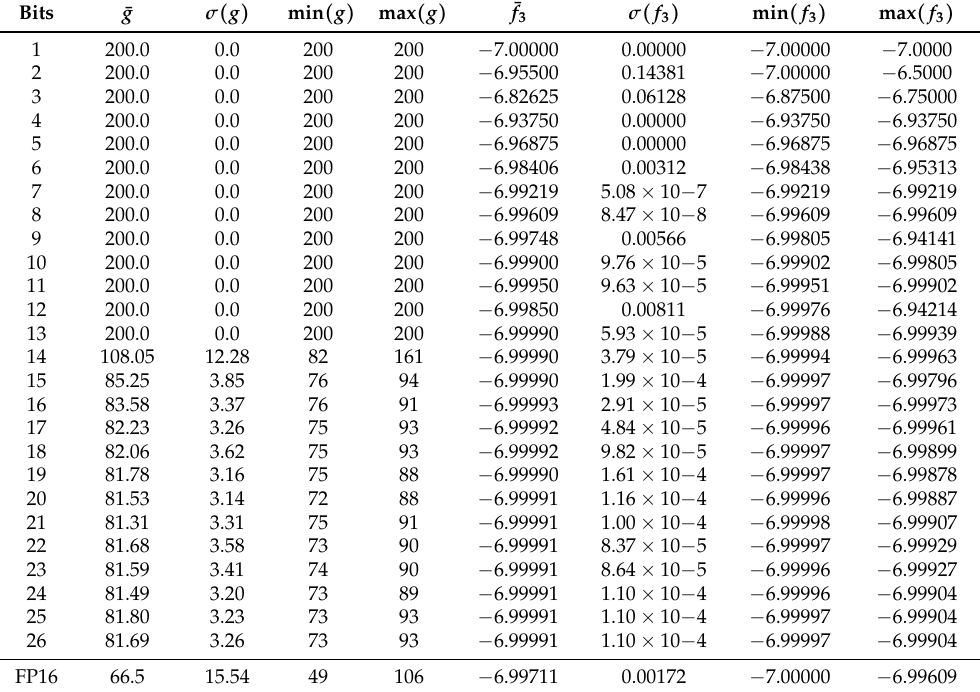
Table 6. Simulation results for Ackley function. Statistics of the 100 runs per bits used in the fractional part for the fixed point arithmetic (5 bits were used for the integer part). Results for 100 runs for the FP16 are also shown. g is the number of generations.